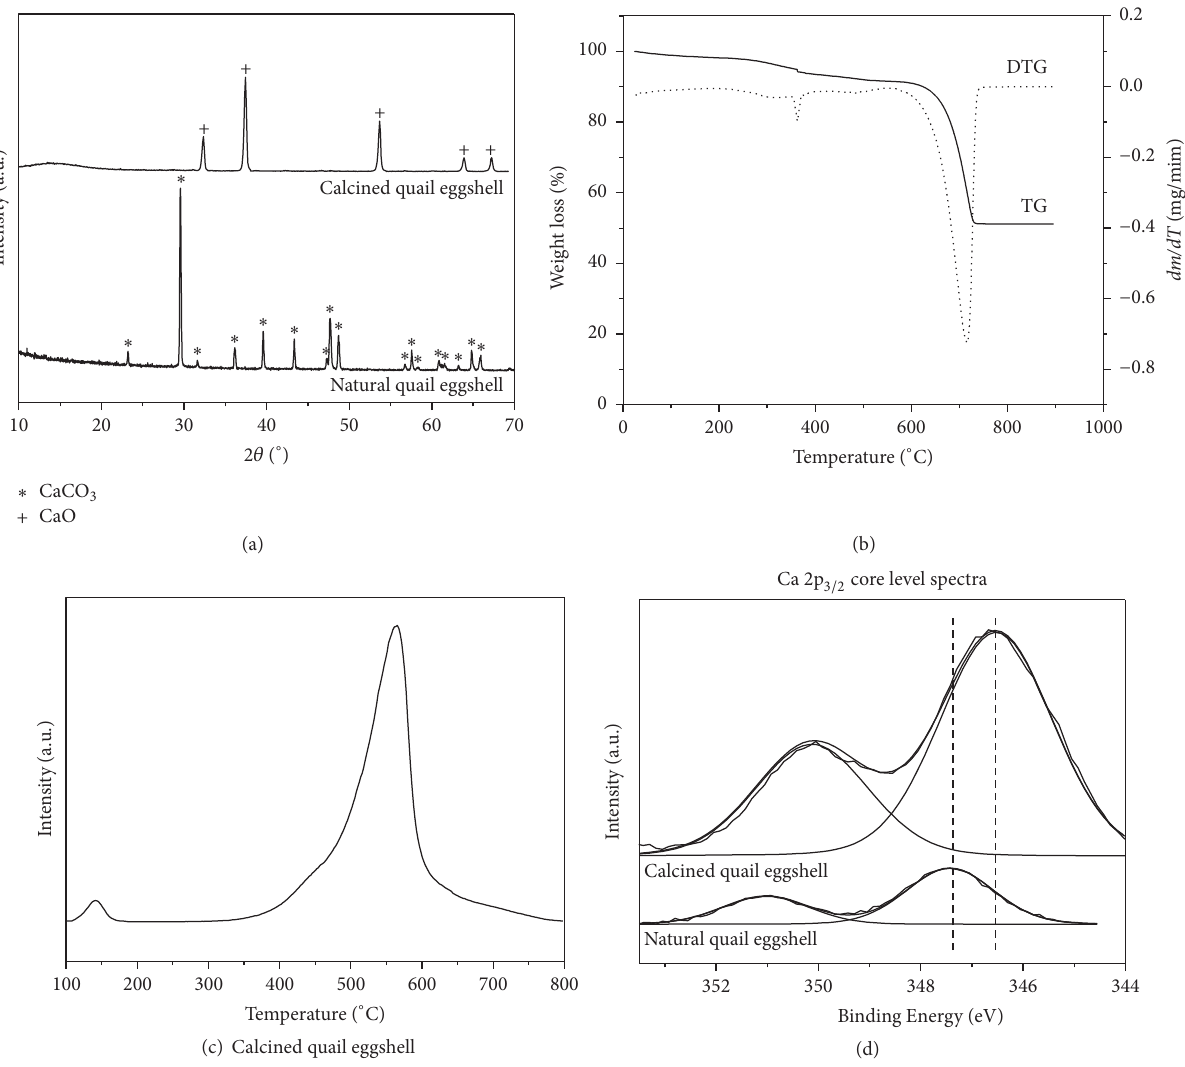
Figure 2: X-ray diffraction of natural and calcined quail eggshell (a), TG/DTG of natural quail eggshell (b), CO 2 -TPD profile of calcined quail eggshell (c), and Ca 2p core level spectra of natural and calcined quail eggshell